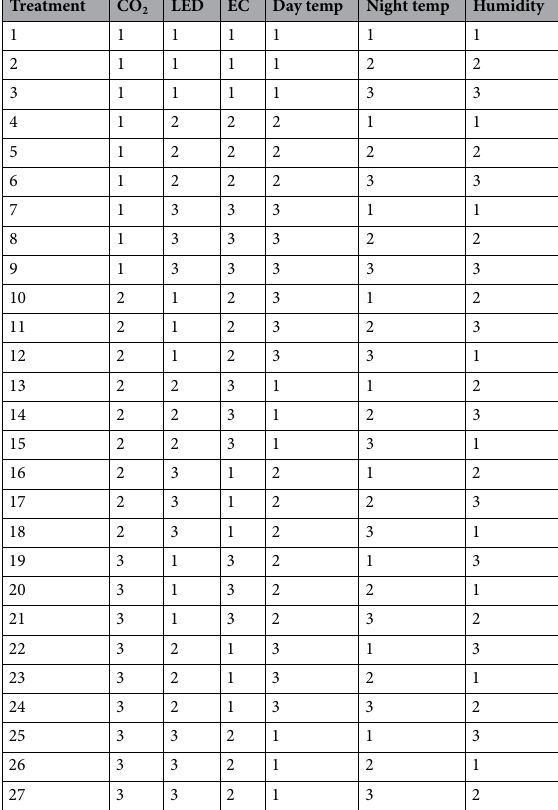
Table 3. The selected trials designed by Taguchi method in the present